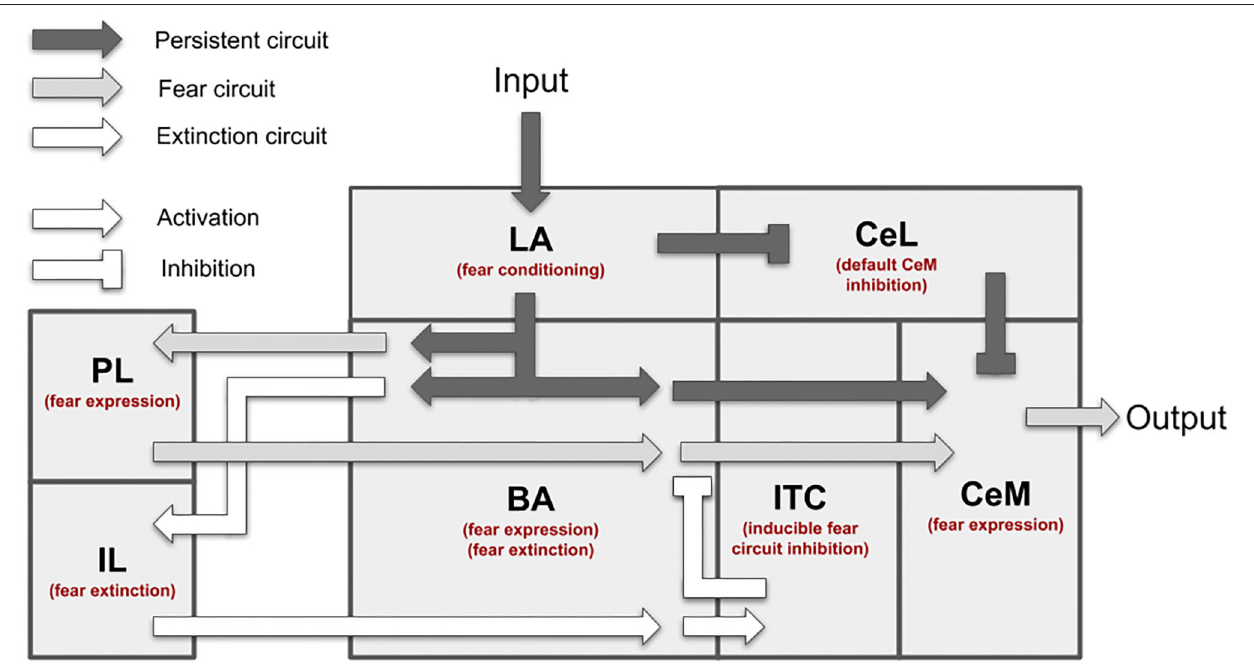
FIGURE 1 | Overview of the brain areas reproduced by the model, and their main connections and functions played in conditioning and extinction. The scheme shows how the input (CS, US) is conveyed from LA to CeM through three main circuits: a persistent circuits (LA-BA-CeM and LA-CeL-CeM), a fear circuit